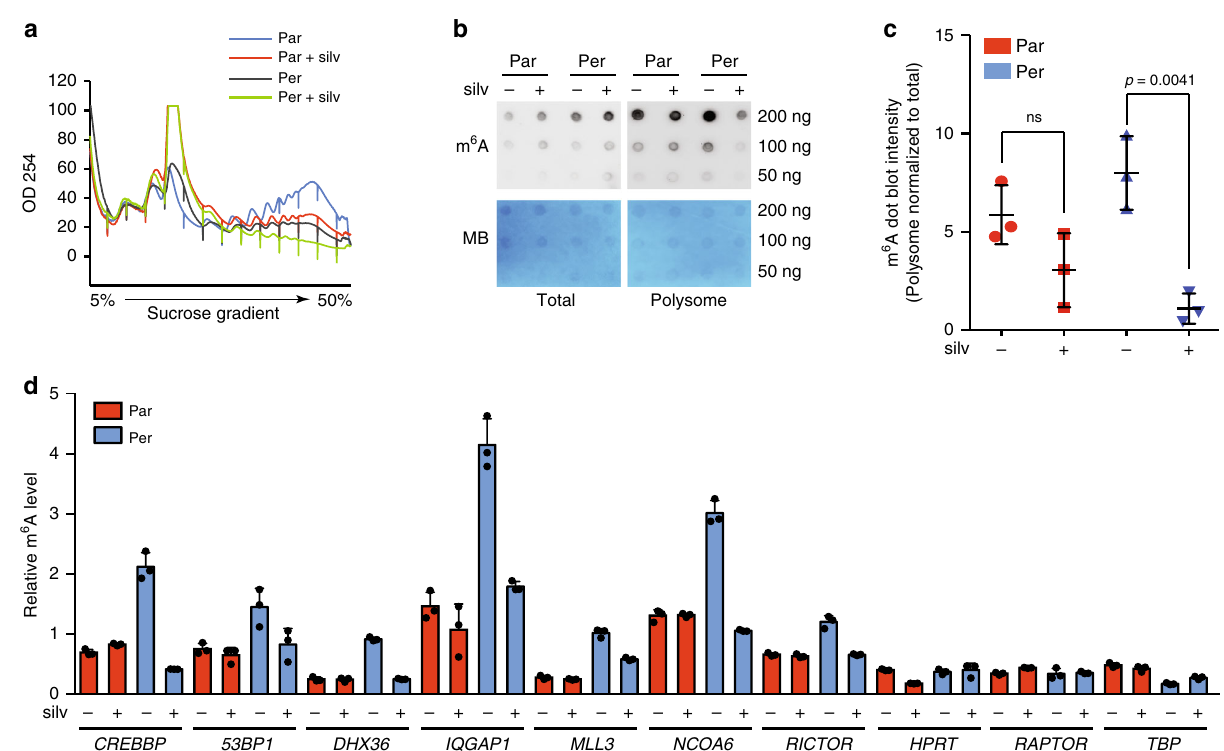
Fig. 6 Silvestrol decreases the m 6 A enrichment in mRNAs from polysome fractions. a Polysome pro fi les of persister (Per) vs. parental (Par) cells in the presence or absence of silvestrol (silv, 30 nM for 4h). b , c Total mRNAs and polysome-bound mRNAs were puri fi ed for m 6 A dot blot analysis ( b ) and the semi-quanti fi cation of the dot blot intensity ( c ). Polysome-derived mRNA m 6 A intensity was normalized to the total lysate (input)-derived mRNA m 6 A. n = 3, unpaired t -test. d RT-qPCR quanti fi cation of m 6 A enrichment in the translationally upregulated mRNA in persister cells upon the indicated treatment ( n = 3, ** p -value < 0.01, unpaired t -test). The raw data of c and d are available in Source